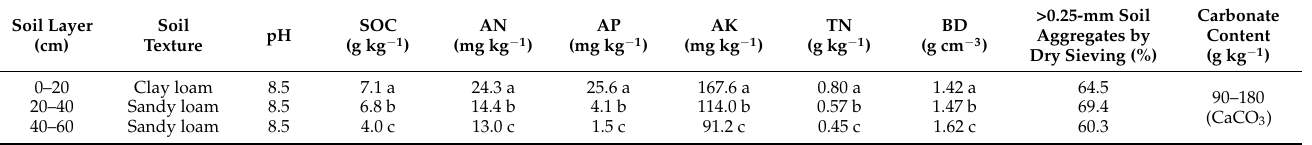
Table 1. Key properties of the soil layers (0–60 cm in